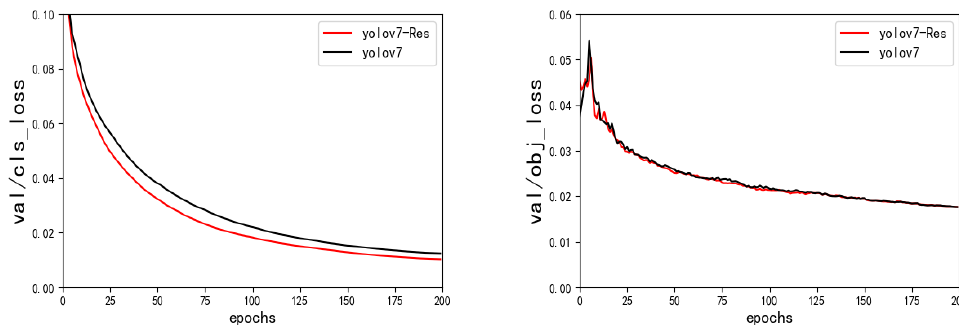
Figure 10. Results of the YOLOv7-Res3Unit ablation experiment. Table 3. Network performance of YOLOv7-Res3Unit.